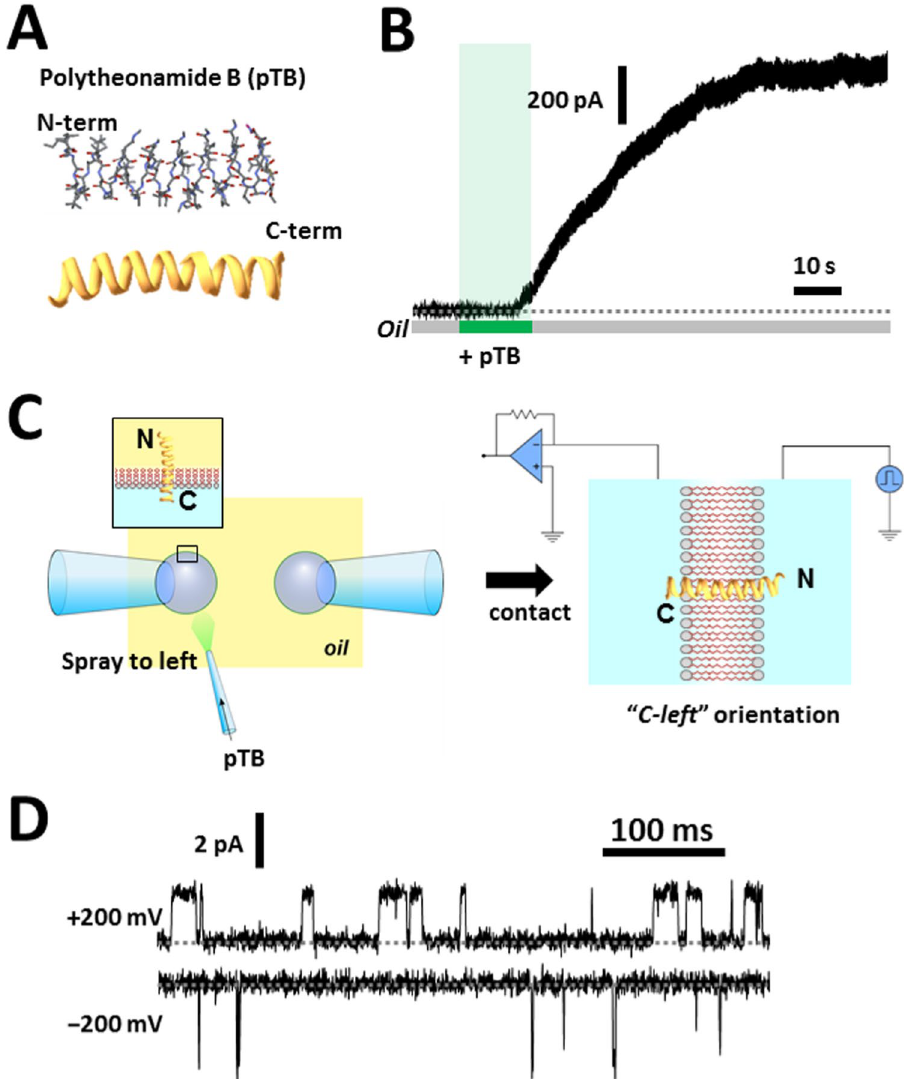
Figure 2. Channel molecule administration via the oil-phase route. ( A ) Structure of the pTB channel. ( B ) Administration of pTB at the vicinity of the DiphyPC membrane. pTB is a hydrophobic peptide, which was dissolved in hexadecane (50 nM) and applied to the oil phase. After application for 15 s, the channel current emerged after a delay and kept activating, even after stopping the perfusion, indicating that pTB partitioned into the monolayers was transferred to the bilayer. ( C ) Scheme for the vectorial insertion of pTB. When pTB was sprayed on one of the bubbles and the bubbles were attached, the orientation of the pTB channel in the membrane was controllable. Inset. The hydrophilic C-terminal rests in the aqueous phase, while the hydrophobic N-terminal stays in the hydrophobic phase. ( D ) The single channel current recording of the pTB channel. The channel current appeared immediately upon attaching the bubbles after spraying pTB (50 pM) to one of the bubbles. Conductance and open probability of the pTB channel is asymmetric to the applied membrane potential, consequently, the orientation is distinguishable.